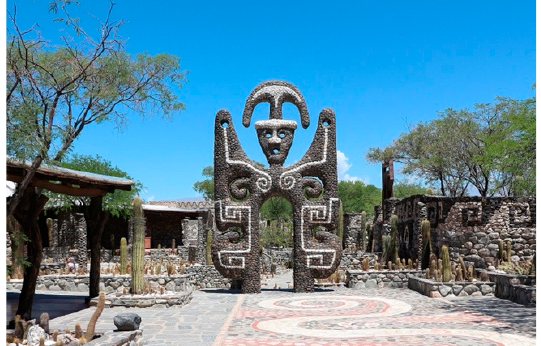
Figure 1. Pachamama, Pachamama Museum, Amaicha del Valle, Argentina. Photo by Bernard Gag-